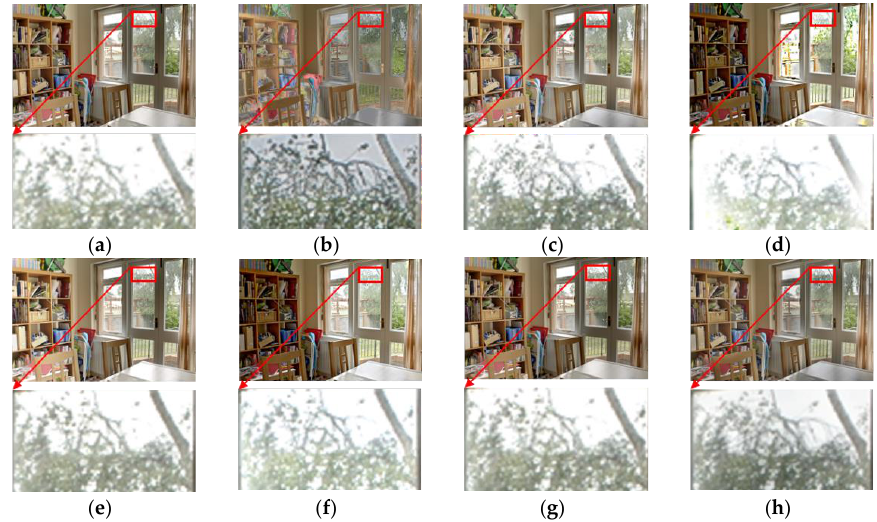
Figure 7. Fusion results for Figure 4c. ( a ) Mertens et al.’s method [ 16 ] . ( b ) Shen et al.’s method [ 21 ] . ( c ) Li et al.’s method [ 22 ] . ( d ) Ma et al.’s method [ 24 ] . ( e ) Hayat et al.’s method [ 25 ] . ( f ) Qi et al.’s method [ 27 ] . ( g ) Huang et al.’s method [ 28 ] . ( h ) The proposed method.